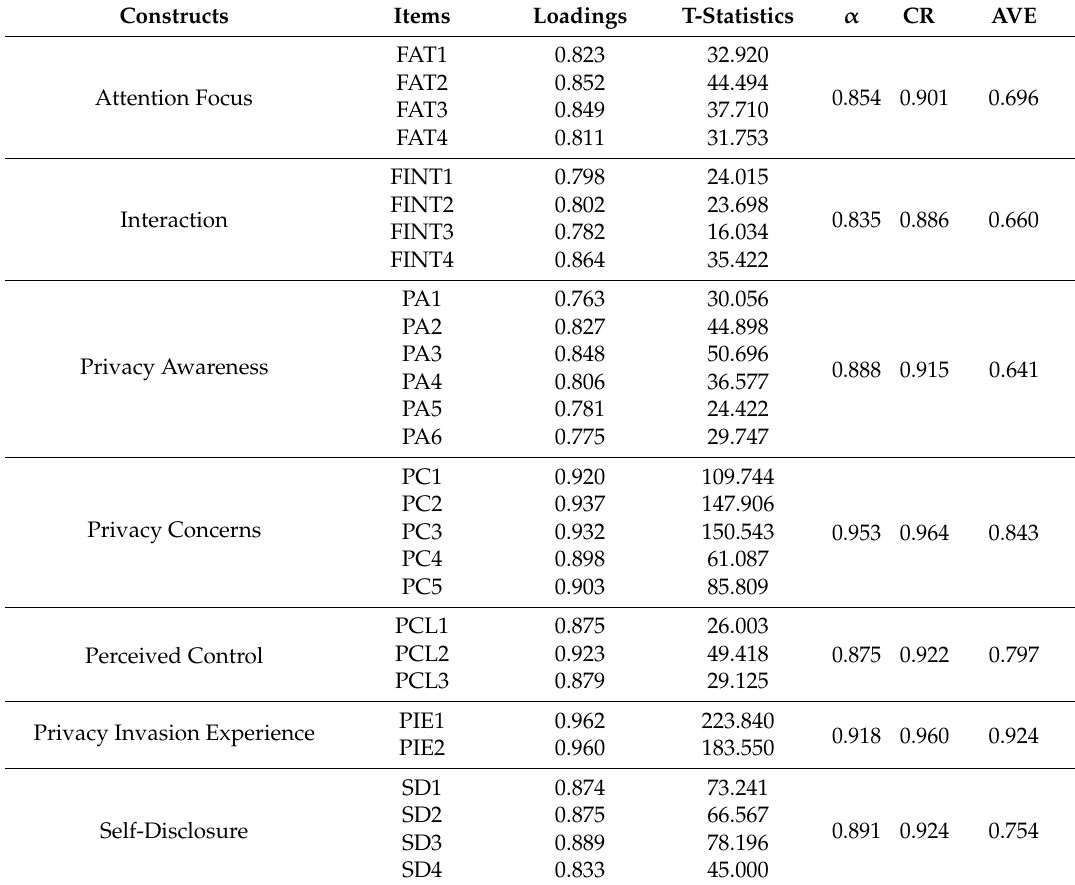
Table 2. Results of reliability and convergent validity